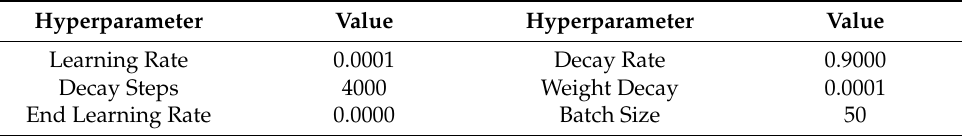
Table 3. Values of